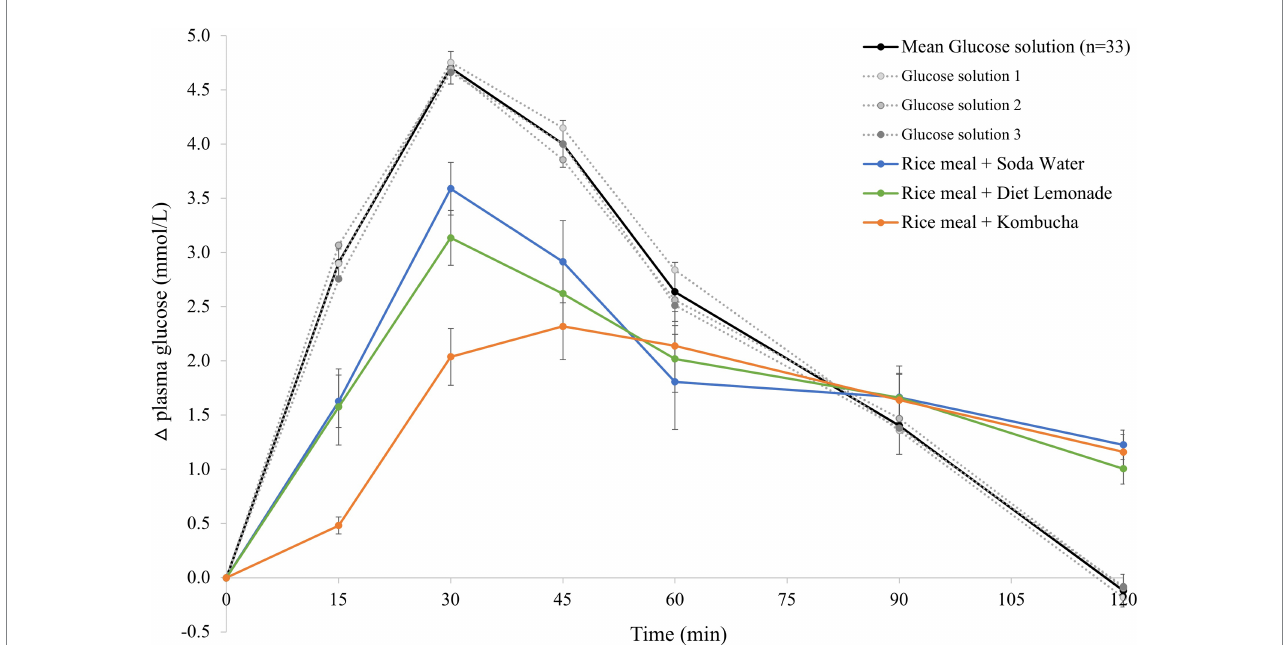
FIGURE 1 Postprandial glycemic response after test meals. Mean 120 min plasma glucose response curves in 11 healthy participants for the reference glucose solution and the three Jasmine rice-based test meals containing different beverages, shown as the change in plasma glucose from the fasting baseline level. Data are shown as mean ± standard error of the mean (SEM), n = 33 for the three repeated glucose solution tests (shown in black, with the three individual glucose solution tests ( n = 11) shown in grey dotted lines), n = 11 for each of the three treatments: soda water meal (shown in blue), diet lemonade soft drink meal (shown in green) and kombucha meal (shown in orange).